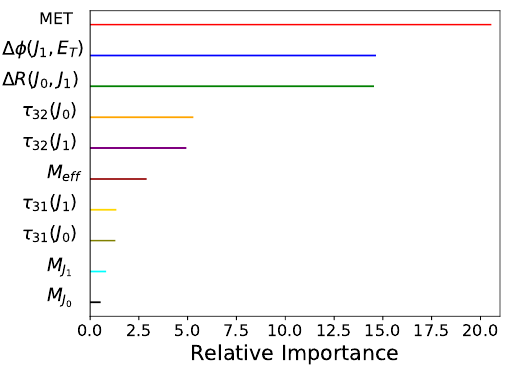
Figure 7. Relative importance (Method unspecific) of the different kinematic variables used in MVA. We get those numbers for BP3 from the TMVA package. Those numbers can change a little bit if one chooses a different algorithm.